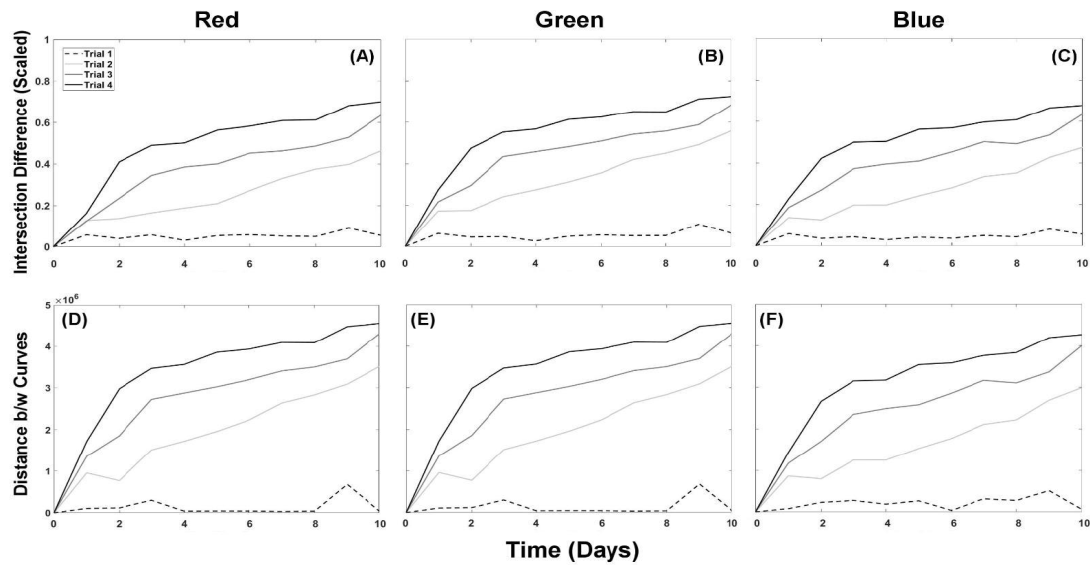
Figure 9. Intersection analysis with curve differences for R, G, and B ( A – C ) on top and the minimum cumulative difference in distance of R, G, and B curves between day-0 and consecutive day images as determined using DTW vs. time ( D – F ) on the bottom. The control (dashed line) remained within a narrow range, while treated trials continued to show a larger difference with increasing Cu doses delivered over time (Table 1).